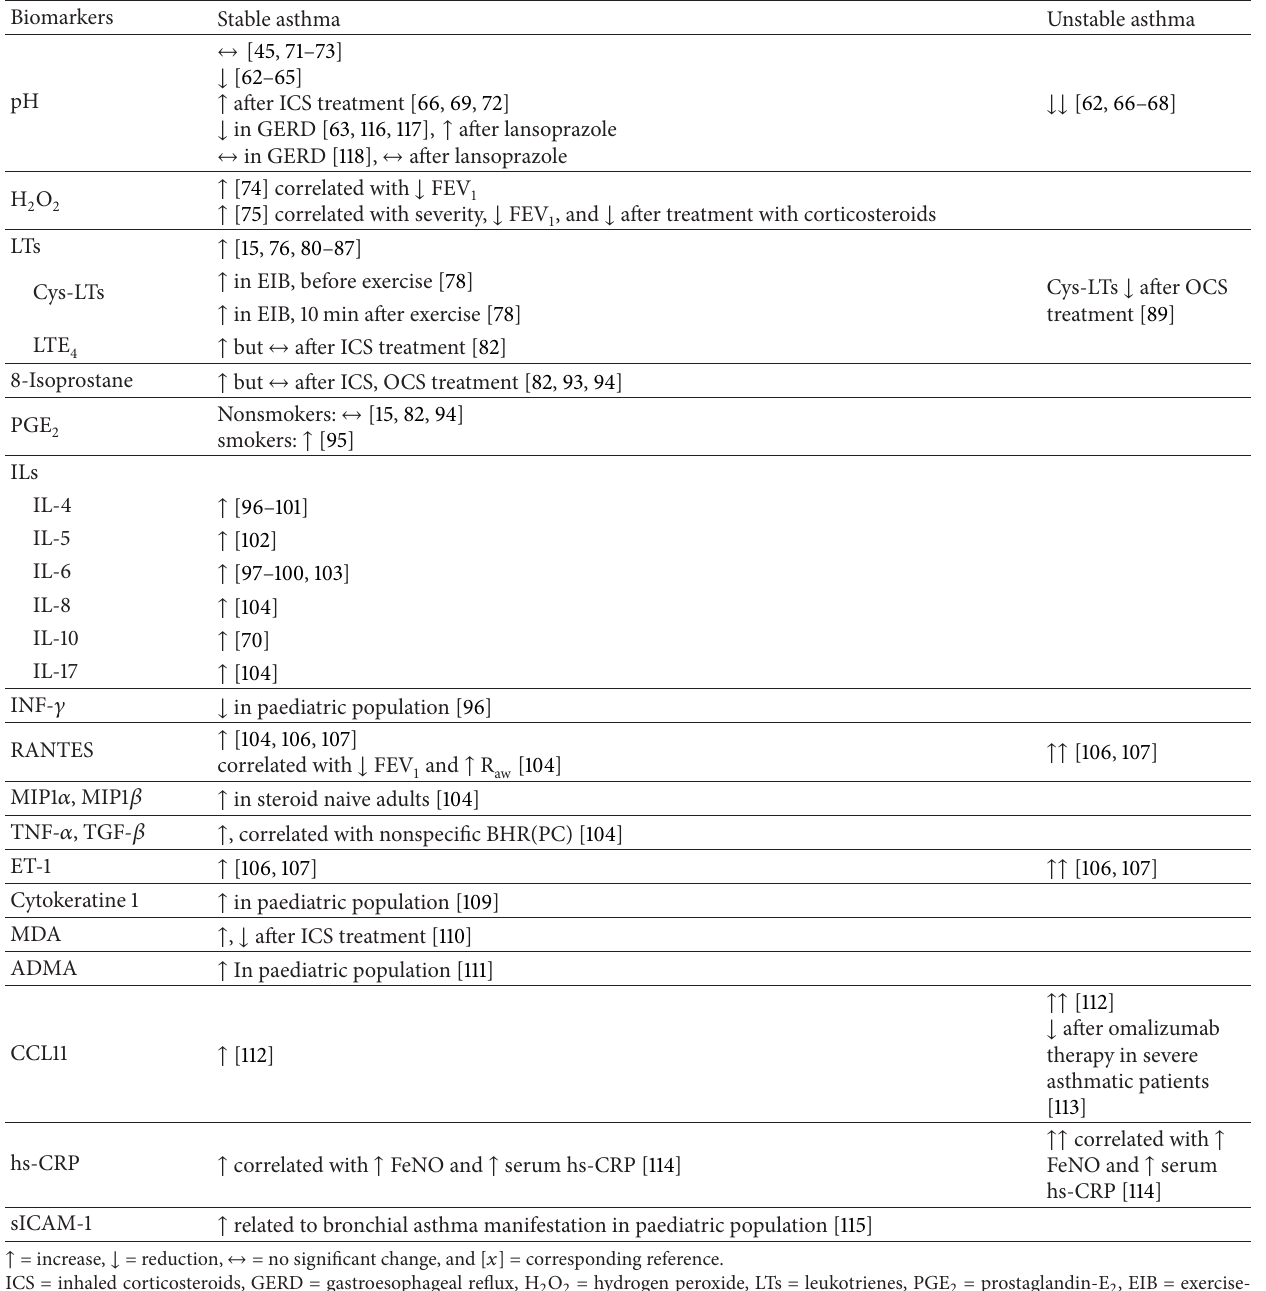
Table 1: Changes of exhaled breath condensate biomarkers in